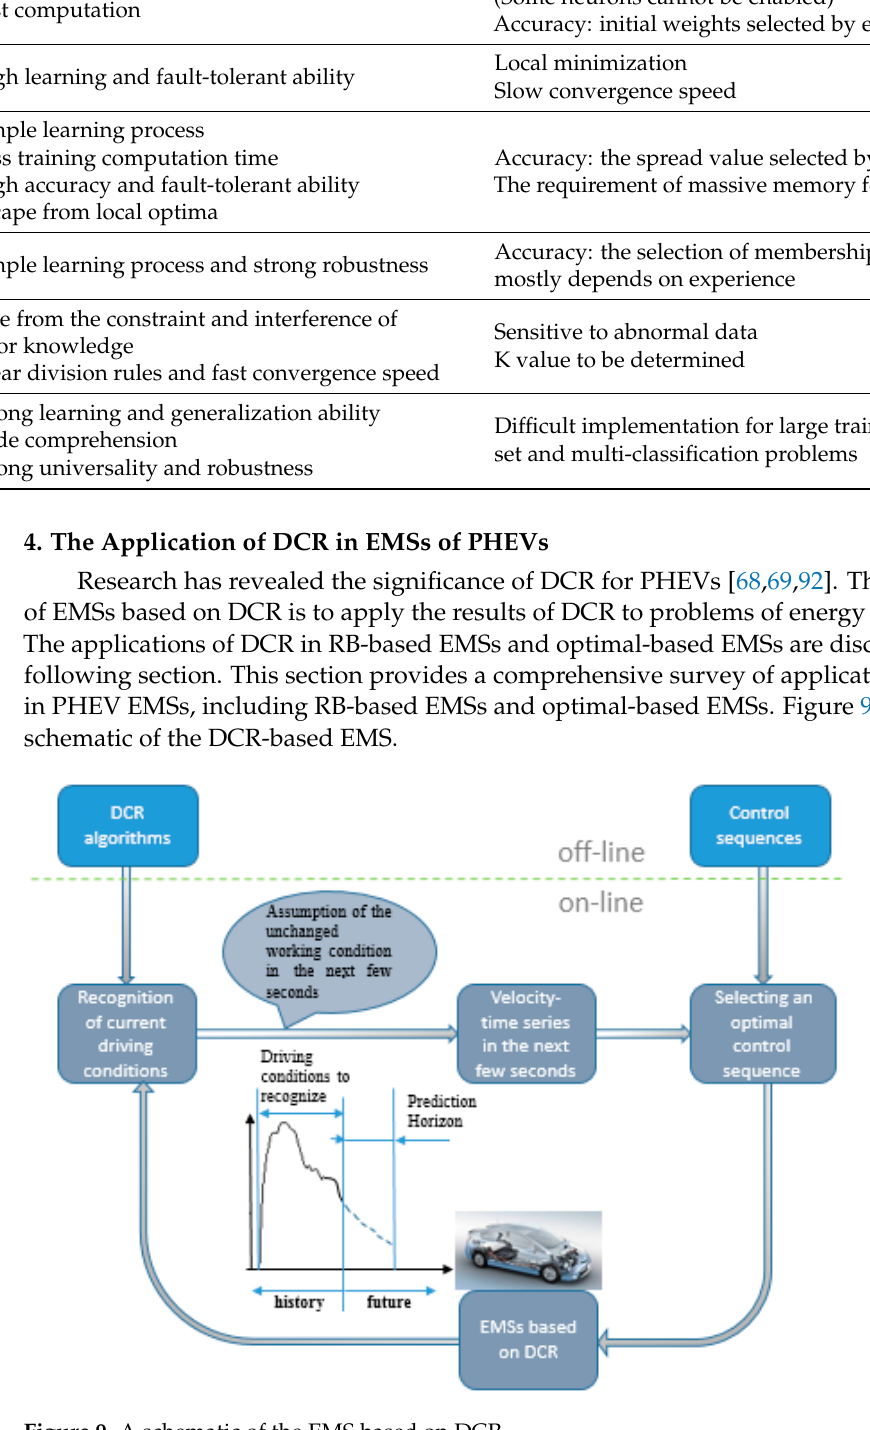
Figure 9. A schematic of the EMS based on